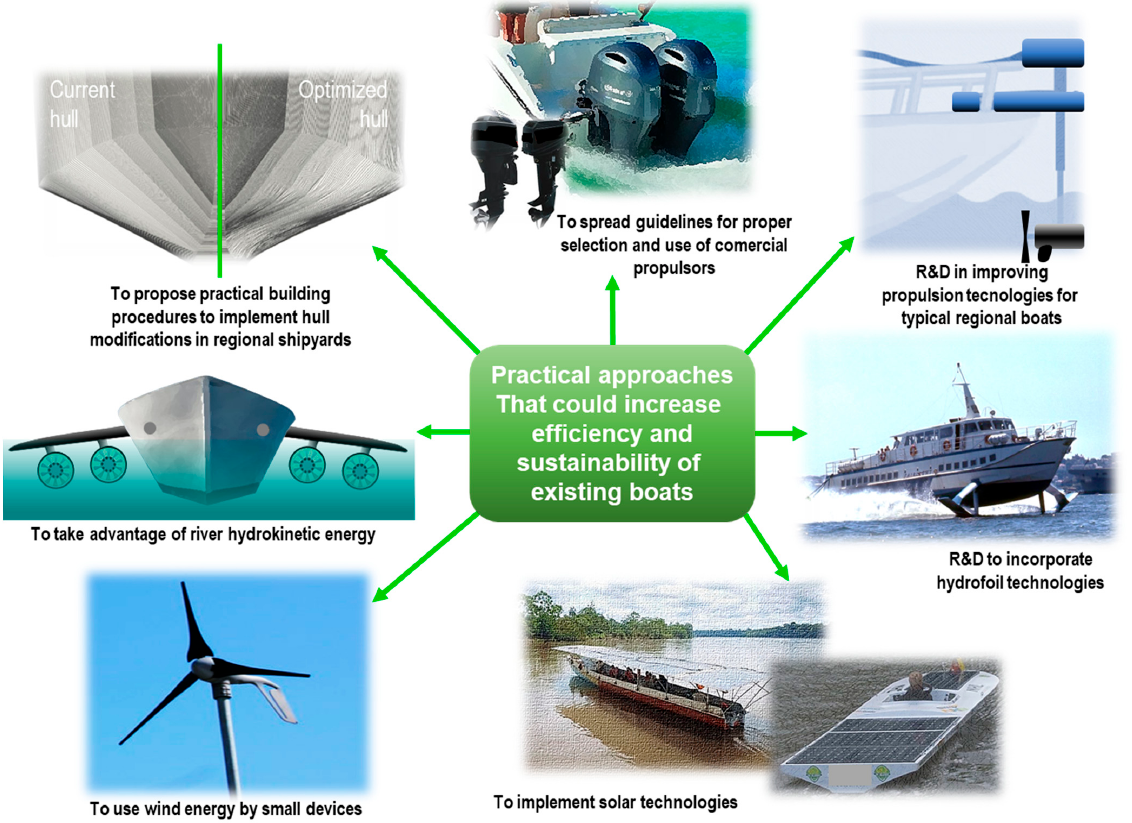
Figure 6. Possible improvements in the efficiency and sustainability of the existing boats used for daily activities in remote regions of the Amazon and similar regions elsewhere. Adapted image credits: commercial propulsors [89]; hydrofoil technologies [90]; solar technologies (left: [80], right: [83]); wind energy [91].